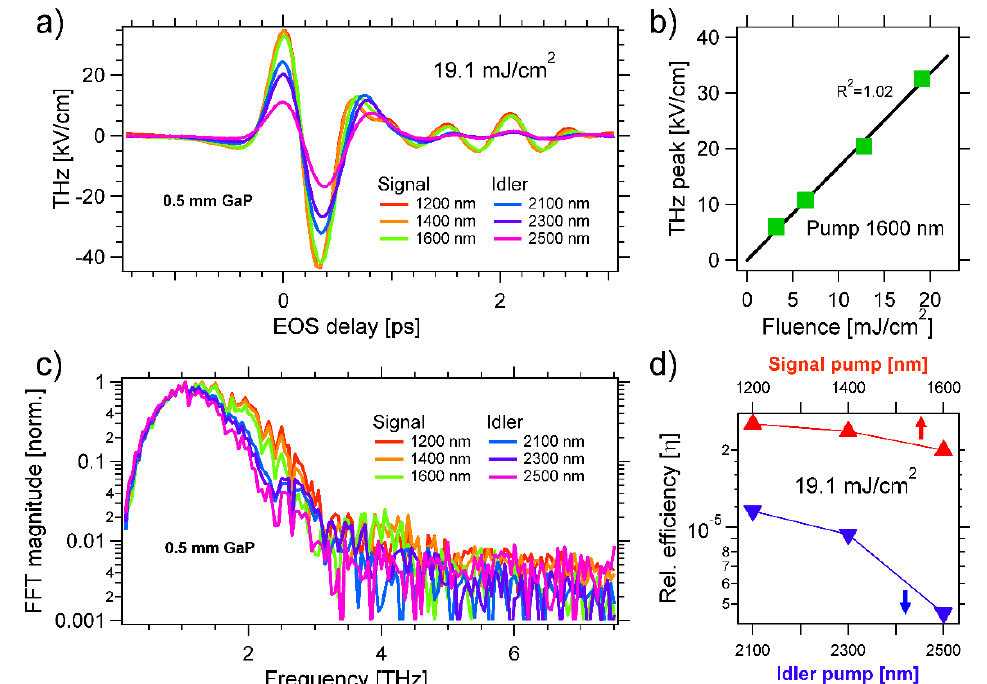
Figure 2. ( a ) Phase-resolved THz fields emitted by optical rectification in 0.5 mm thick GaP crystal. We use as pump pulses the output of an optical parametric amplifier between 1200 and 2500 nm. The pump fluence is set to 19.1 mJ / cm 2 for all pump wavelengths ( λ P ). The THz is detected by electro-optical sampling (EOS) in another 0.5 mm thick gallium phosphide (GaP) crystal. We use an additional 90 fs long sampling beam at 790 nm for EOS. ( b ) We set the pump to λ P = 1600 nm and plot the peak THz field value at t EOS = 0 ps versus pump fluence. We obtain a linear fit with an R 2 value of 1.02, which confirms THz emission by a nonlinear optical process of rectification. ( c ) Normalized spectrum of the THz field as a function of λ P . As expected, the frequency range is increased for shorter wavelengths [84], it is broad at λ P = 1200 nm and narrow at λ P = 2500 nm. ( d ) Estimated conversion e ffi ciency of NIR radiation into THz radiation as a function of pump color. The e ffi ciency is η ~3 × 10 − 5 at 1200 nm and decreases for larger λ P .